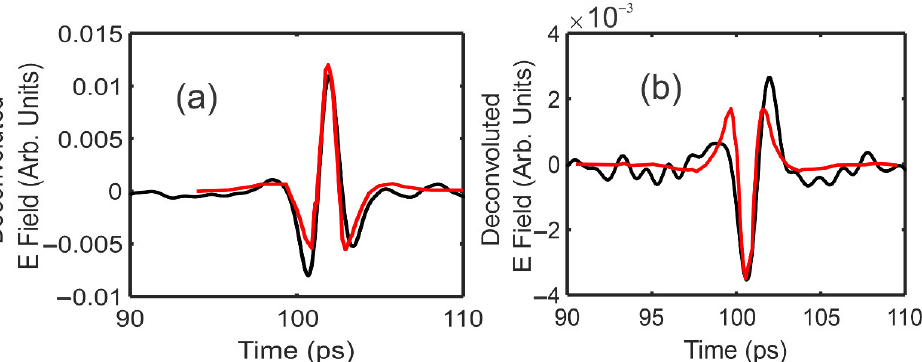
  E t and ( b )   E t and ( b ) o o